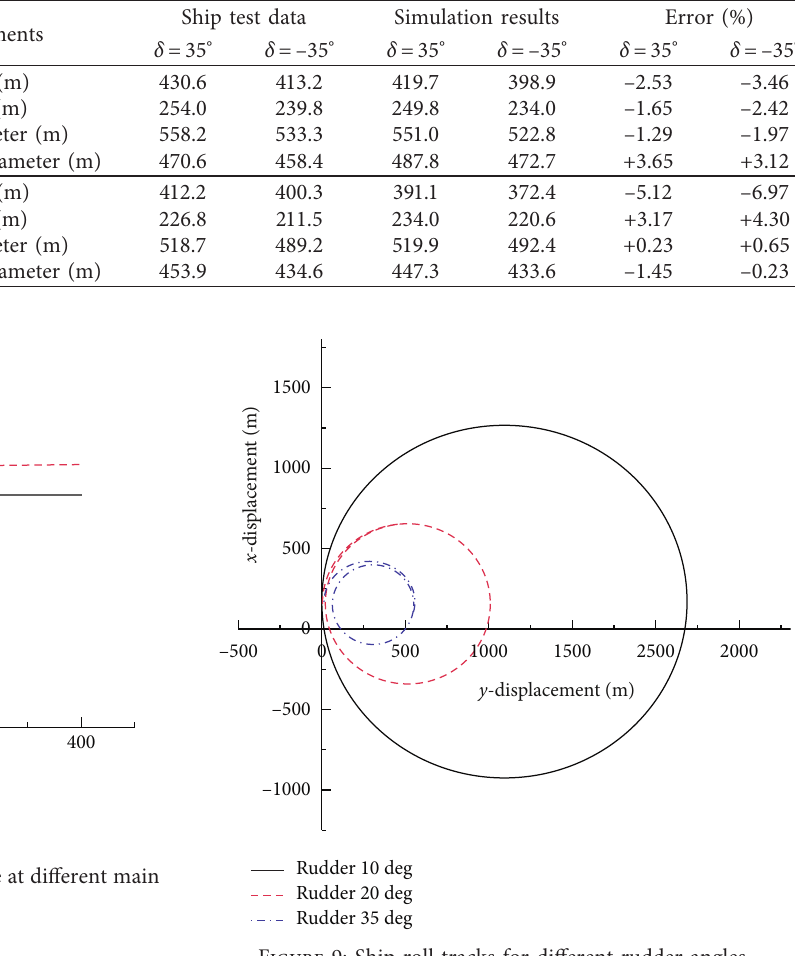
Table 3: Ship turning characteristic parameters.